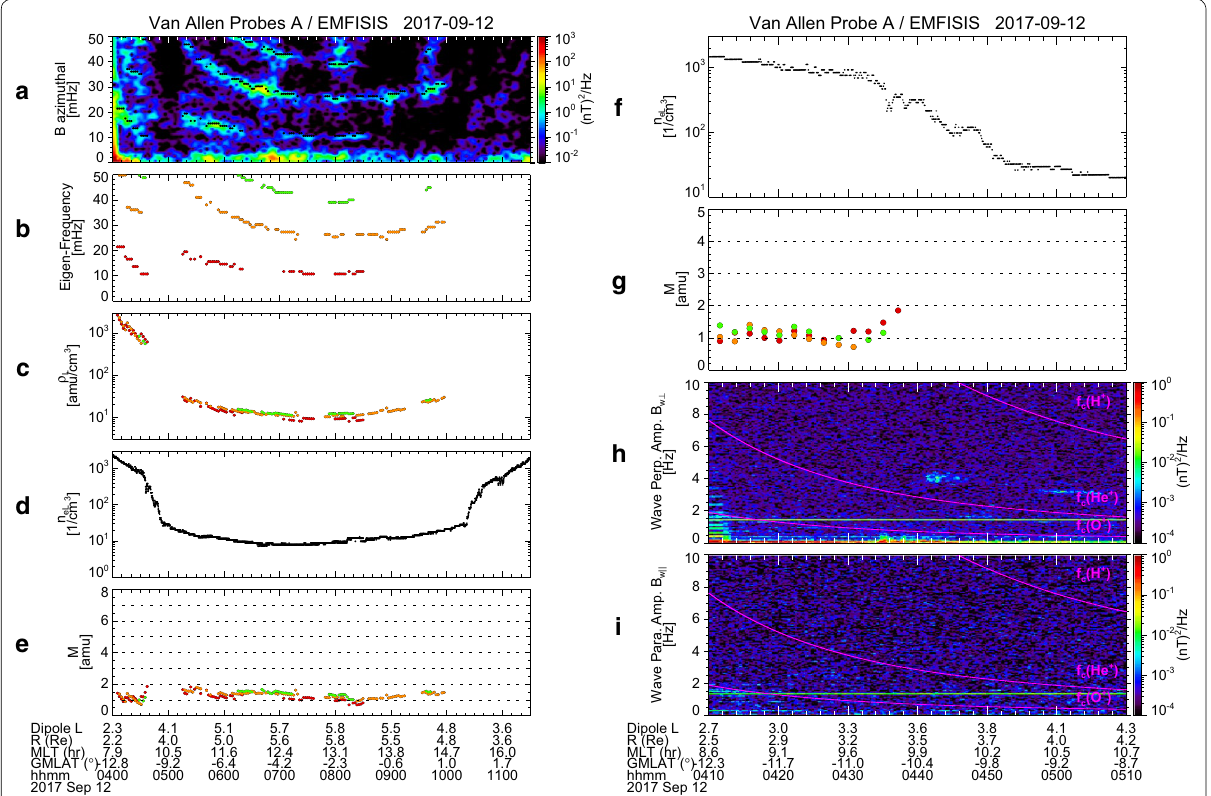
Fig. 10 Van Allen Probe A observations of a the dynamic power spectrum of the magnetic field variations in the azimuthal component with selected peak frequency indicated by black dots, b the selected peak frequency, c mass density at the satellite position, d electron density at the satellite position, and e average plasma mass, during 04:00–11:30 UT on 12 September 2017. Expanded plots during 04:10–05:10 UT of f electron density at the satellite position, g average plasma mass, and h , i the dynamic power spectra of wave amplitudes in the directions perpendicular/ parallel to the local magnetic